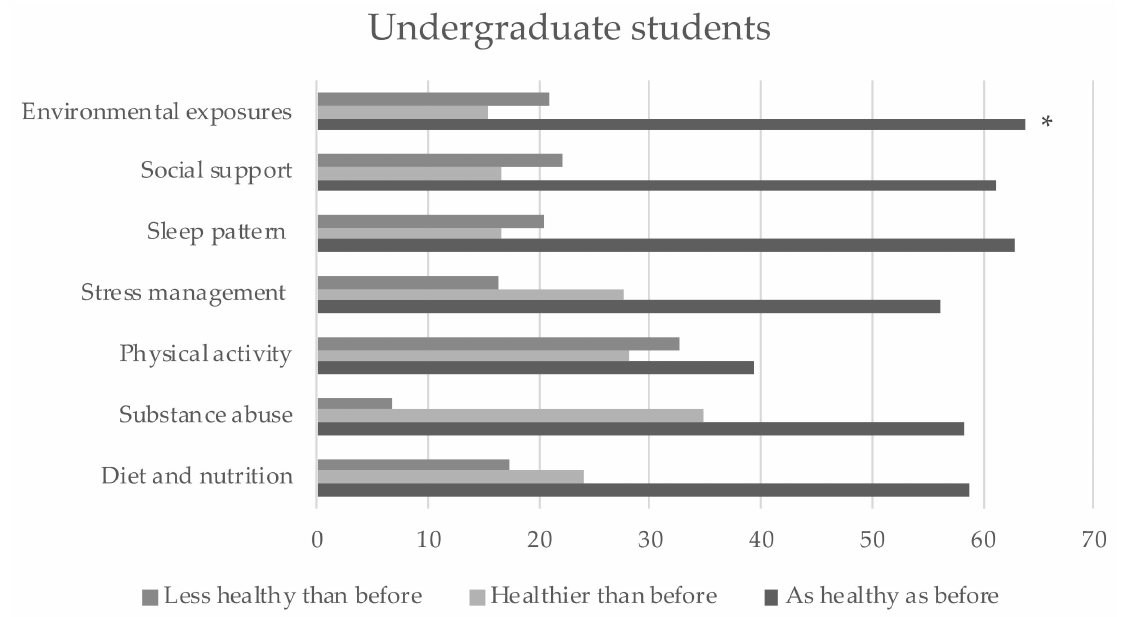
Figure 1. Self-reported changes on lifestyle behaviors during the COVID-19 pandemic in undergraduate students. * Signifi- cant differences ( p = 0.004).